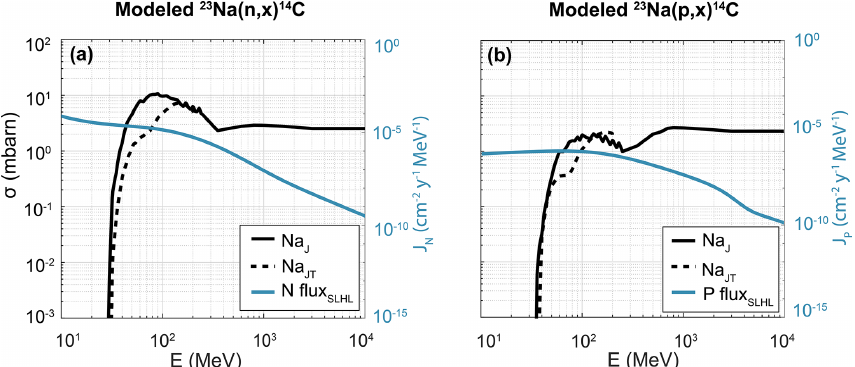
Figure 3. Modeled neutron (a) and proton (b) cross-sections for 23 Na from JENDL/HE-2007 (Na J , solid line) compared to the spliced TENDL-2019 at energies ≤ 0 . 2GeV and JENDL/HE-2007 > 0.2GeV ( 23 Na TJ , dashed line). Differential neutron and proton fluxes at SLHL ( J N and J P , respectively) (Sato et al., 2008) are plotted in their respective panes to illustrate the combined effect of excitation function and flux on in situ 14 C